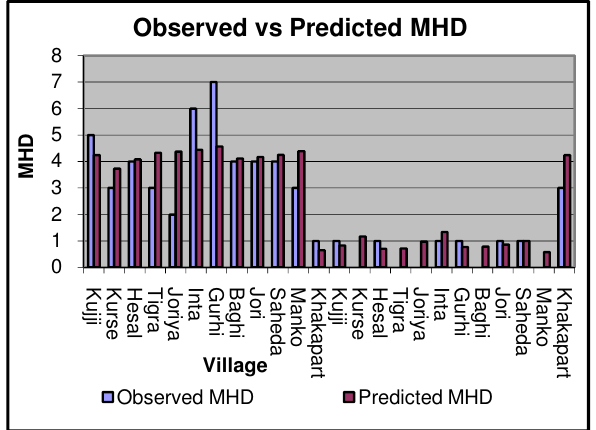
Fig. 6 Graph showing comparison of observed and predicted MHD